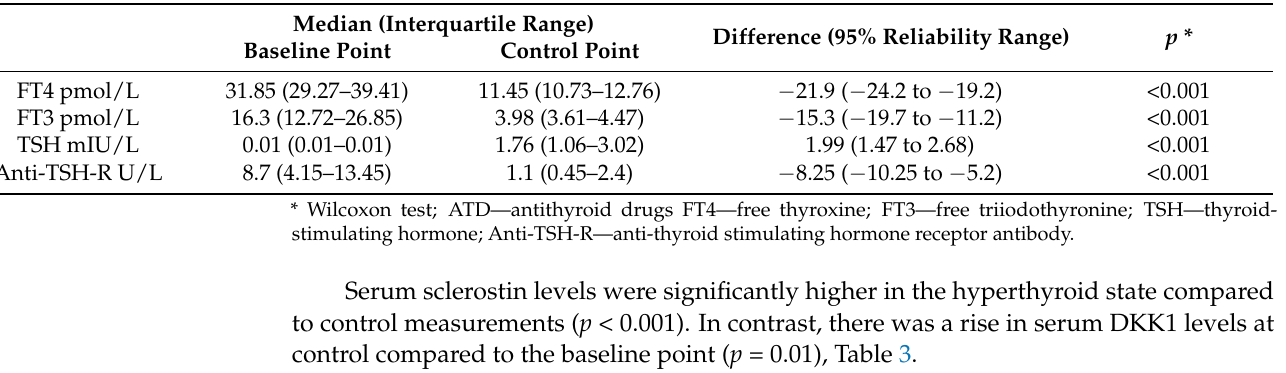
Table 2. Changes in concentration levels of thyroid hormones, TSH, and anti-TSH-R after one year of ATD treatment.